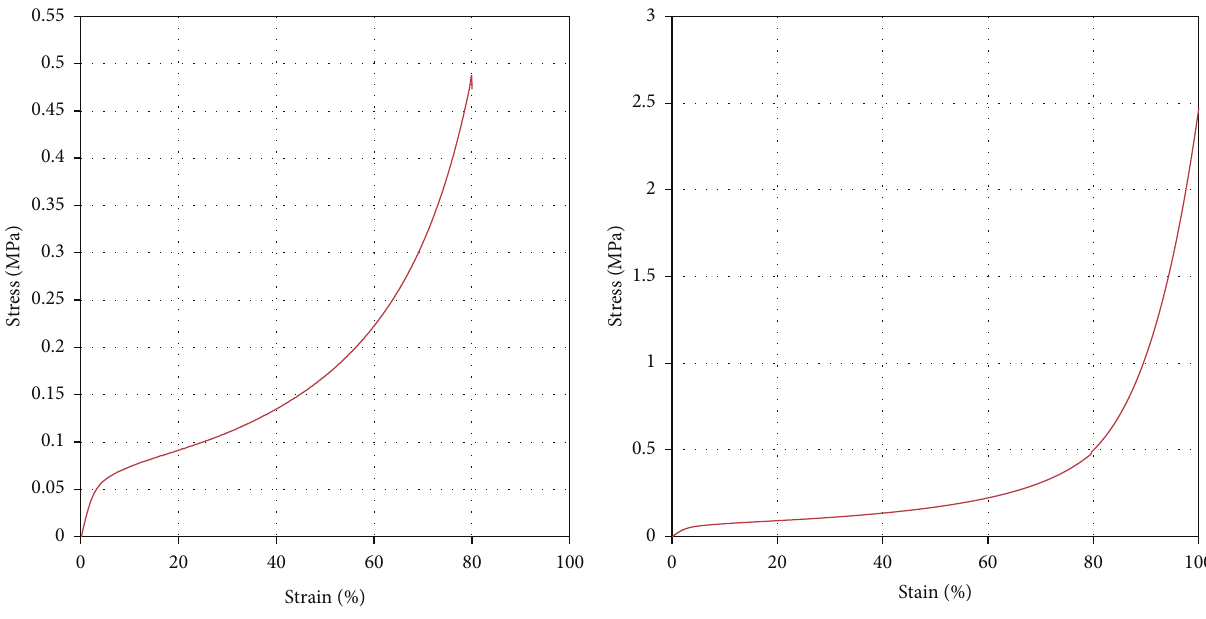
Figure 9: Original (left) and extended (right) stress-strain curve.